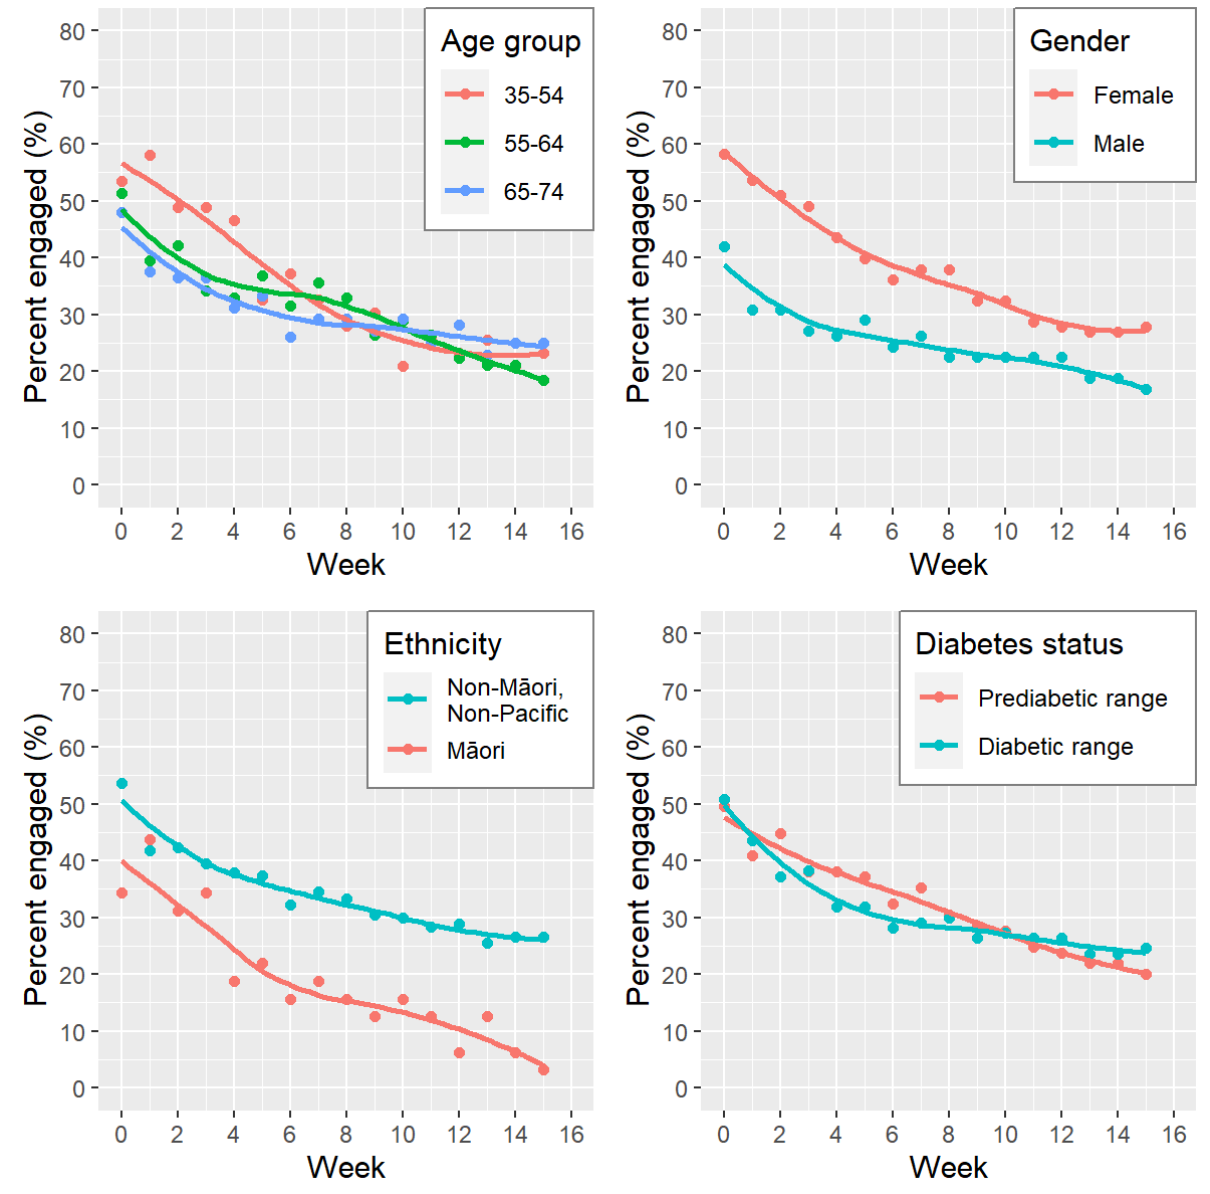
Figure 2. Participant active engagement with BetaMe/Melon portal over time, according to key participant characteristics (age group, gender, ethnicity*, and diabetes status group). *Results for Pacific participants are not presented due to small sample size